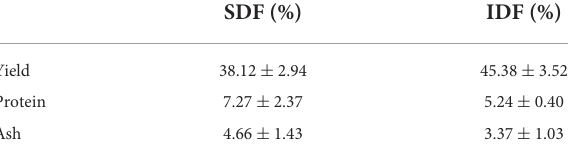
TABLE 1 Components of SDF and IDF.